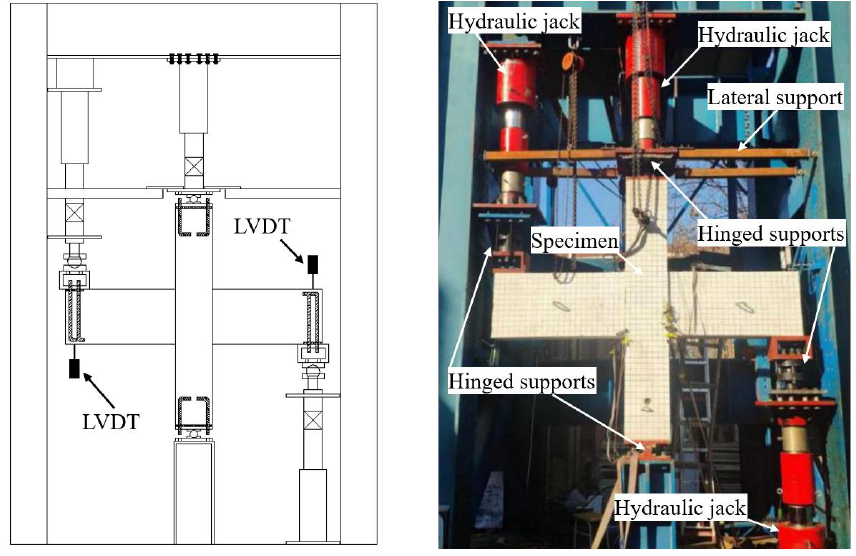
Figure 8. Test set-up.